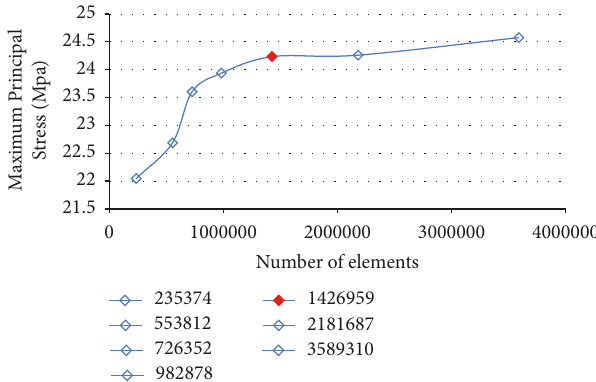
Figure 4: Different layers of the dental crown analyzed and divided for each material